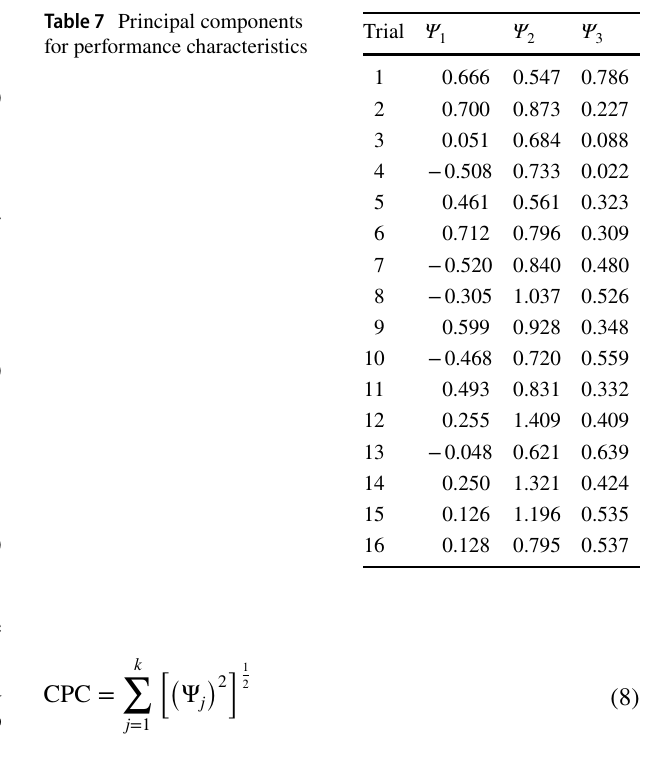
Table 6 Eigen values, Eigen vectors, AP, CAP, principal components